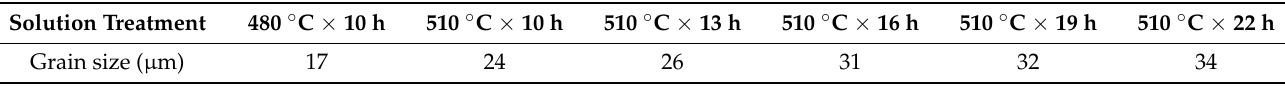
Figure 3. Optical microscopy OM photos of the alloy after different solid solution treatments. ( a ) 480 °C × 10 h. ( b ) 510 °C × 10 h. ( c ) 510 °C × 13 h. ( d ) 510 °C × 16 h. ( e ) 510 °C × 19 h. ( f ) 510 °C × 22 h. Table 2. Grain size of a Mg-13Gd-5Y-3Zn-0.3Zr alloy after different solution treatment. Solution Treatment